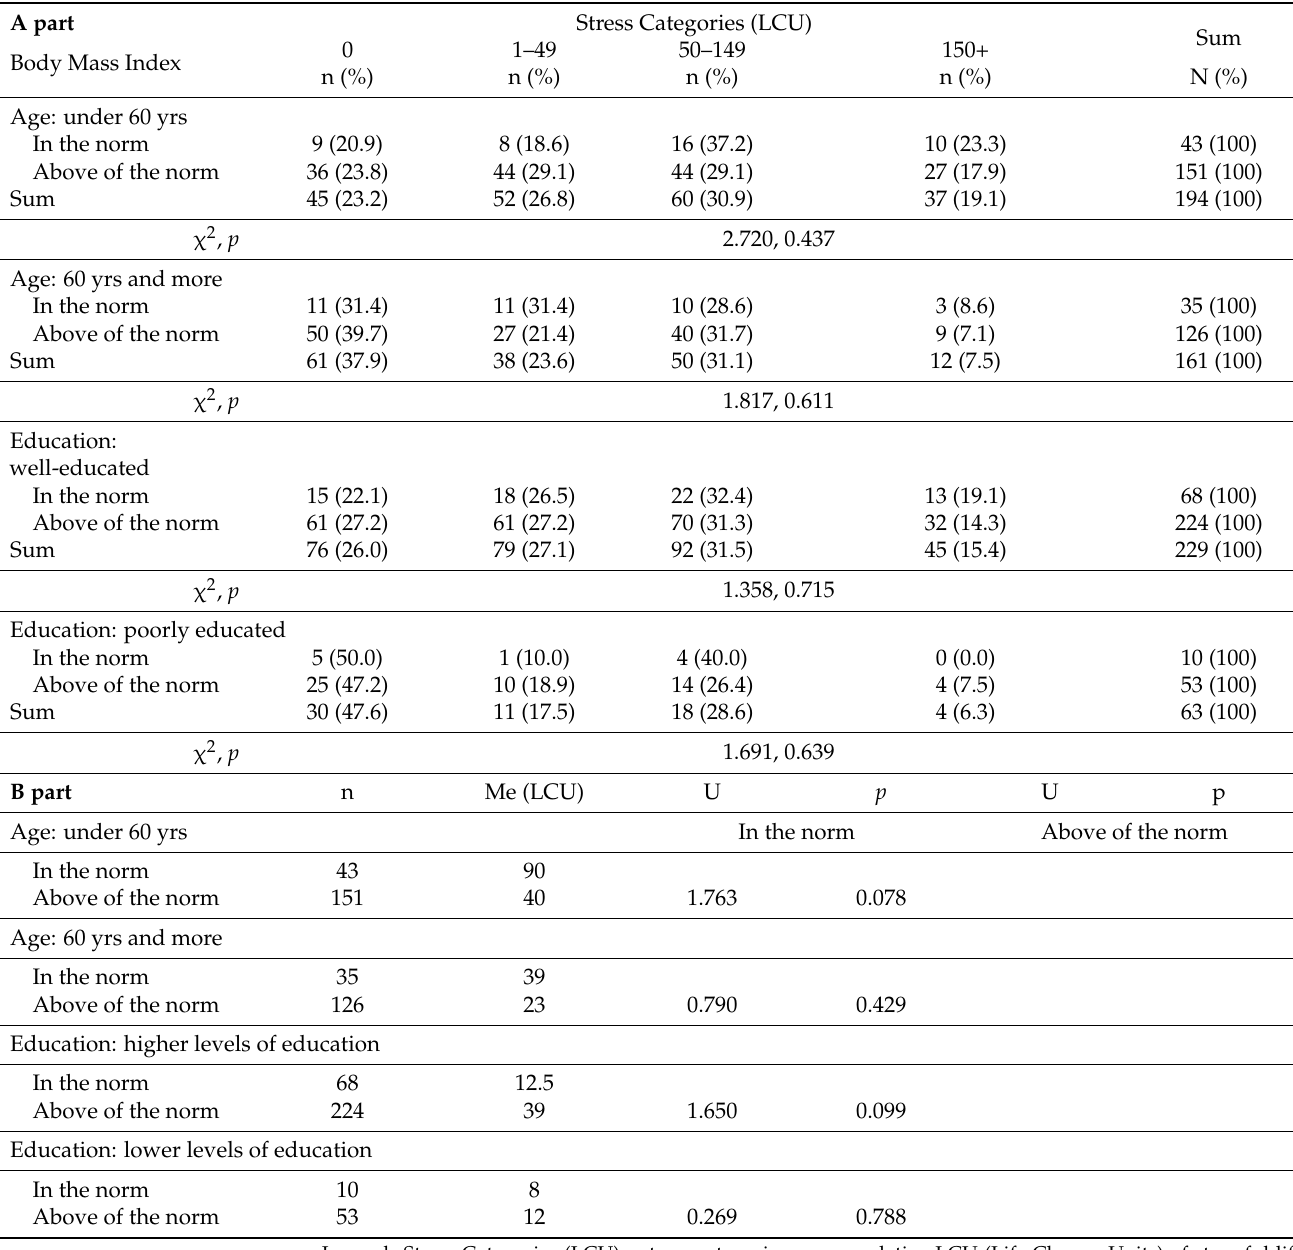
Table 3. Associations of stress with age and BMI category: Part A—number of observations (n) and proportions (%) of stress categories by age and BMI category and results of χ 2 and p ; Part B—results of the Mann–Whitney U test for stress by age and BMI